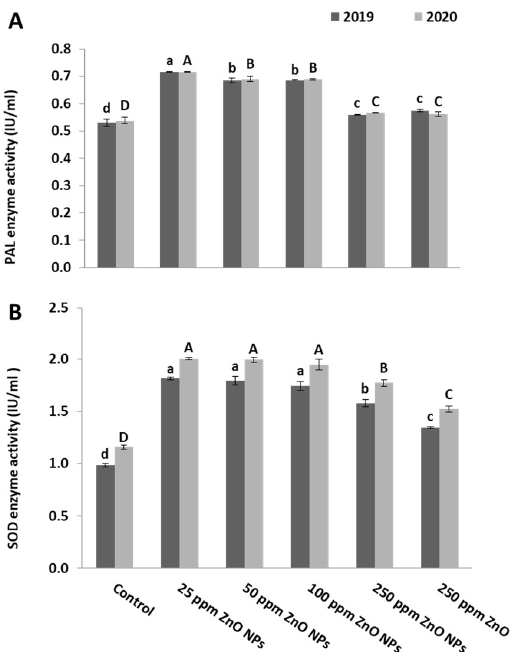
Figure 6. Effect of ZnO NPs foliar spraying on total sugar ( A ) and reducing sugar ( B ) (g/100 g) in berries of Crimson seedless grape cultivar during two seasons: 2019 and 2020. Different letters indicate the differences based on Duncan’s multiple range test.